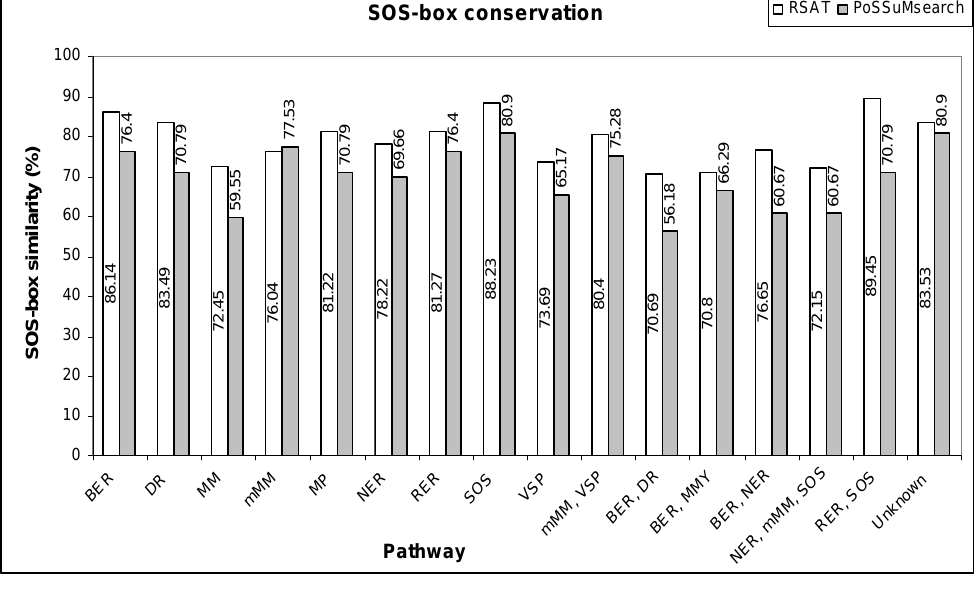
Figure 1: Graphical representation of comparative SOS-box motif conservation (only max. %) predicted through both RSAT & PoSSuMsearch programs in D. radiodurans genes related to replication, repair and recombination